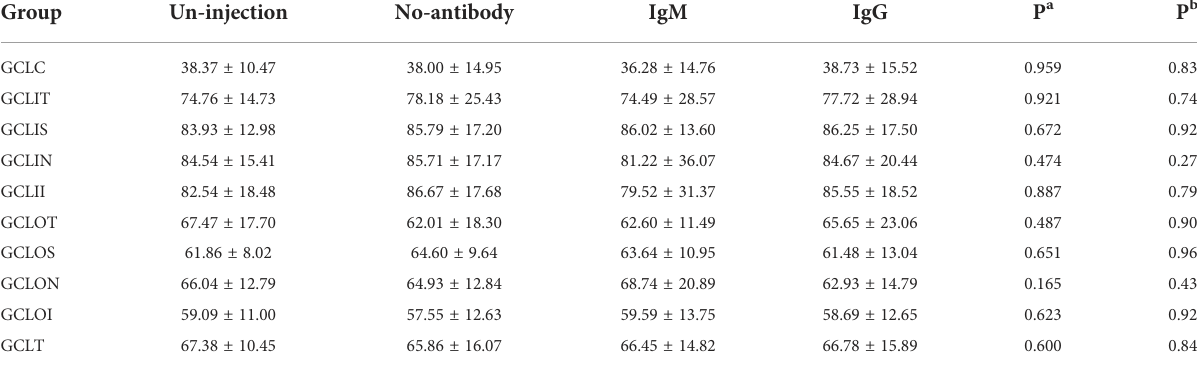
TABLE 4 Analysis of ganglion cell complex thickness in the age-related cataract patients with different COVID-19 antibody statues (median ± IQR, m m). Group